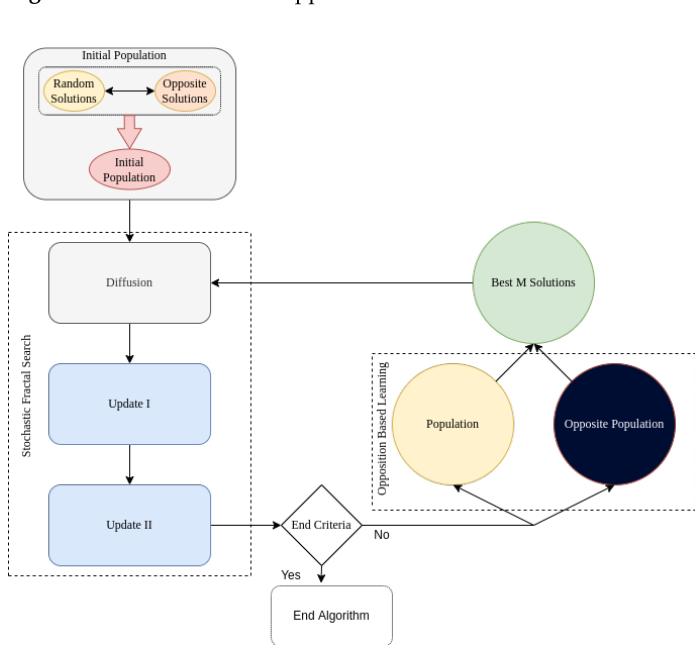
Figure 4. Stochastic fractal search with opposition-based